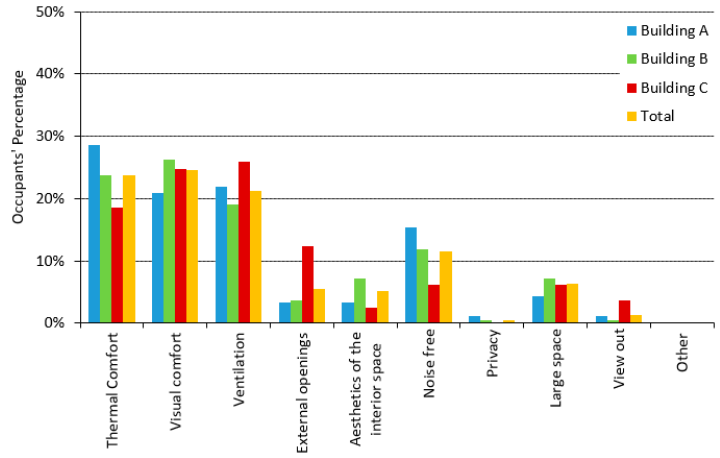
Figure 8. Results of occupants’ opinion of what they want most from the main parameters that a ff ect the overall comfort in an o ffi ce building.